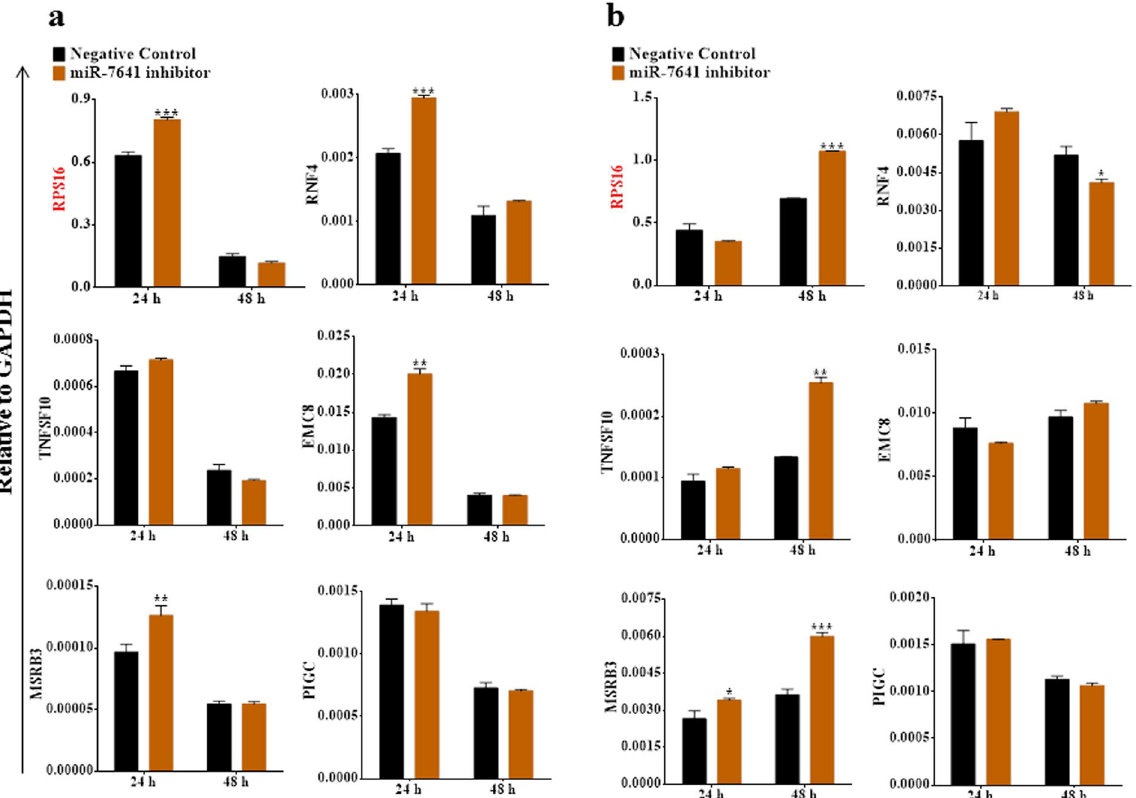
Figure 4. Inhibition of miR-7641 altered target gene expression in breast cancer cells. ( a ) Bar diagrams showing that inhibition of miR-7641 upregulated the expressions of RPS16 , RNF4 , EMC8 , and MSRB3 in MCF-7 breast cancer cells. ( b ) As shown in the bar diagrams, inhibition of miR-7641 upregulated the expressions of RPS16 , TNFSF10 , and MSRB3 in MDA-MB-231 breast cancer cells. Bar diagrams show the mean ± SD obtained from triplicate experiments. * p < 0.05, ** p < 0.01, and *** p <